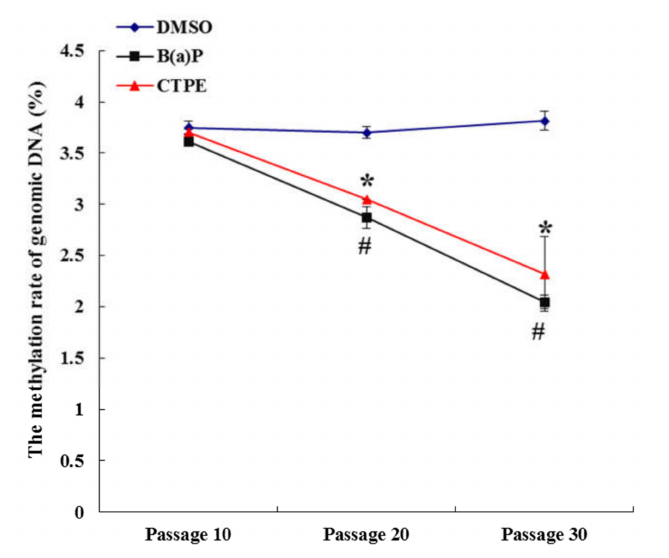
Figure 2. Methylation rates of genomic DNA in the cells from three groups. The methylation rates of genomic DNA in DMSO, CTPE, and B(a)P groups at different detection time points. The results were shown as mean ± SD ( n = 3, *: CTPE vs. DMSO, p < 0.05. #: B(a)P vs. DMSO, p <